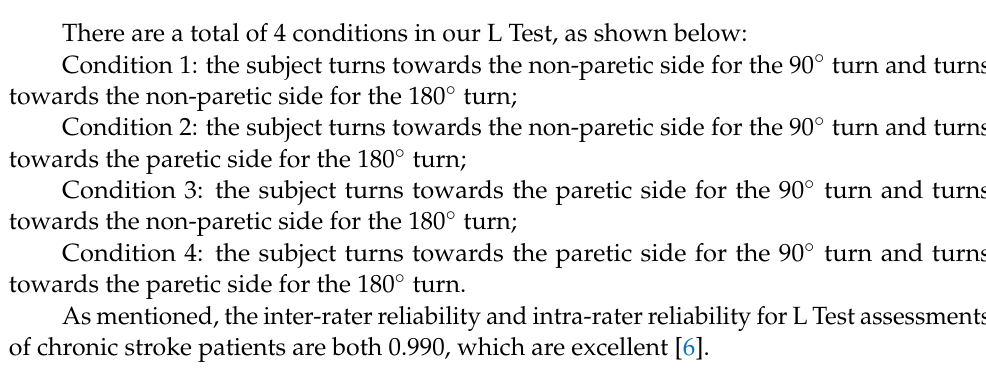
Figure 2. The L Test Protocol.